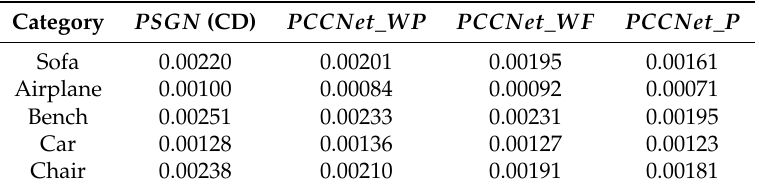
Table 1. CD scores of PSGN and PCCNet .